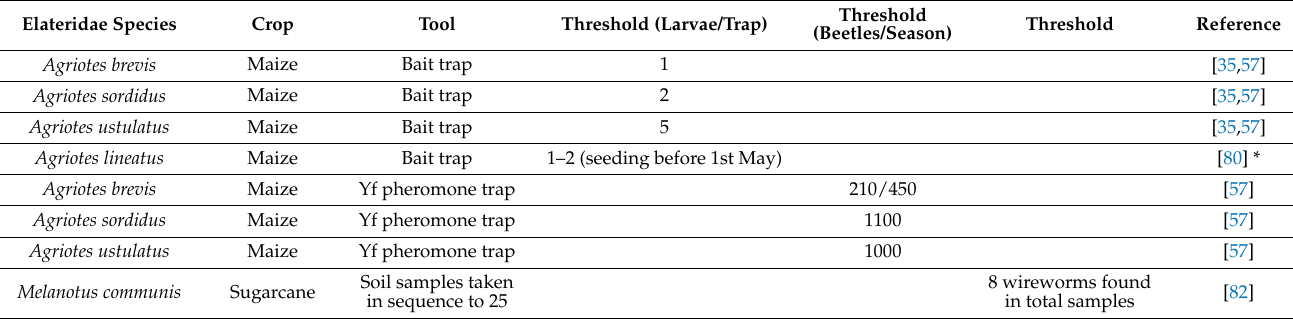
Table 2. Published damage thresholds according to click-beetle species, crop, and monitoring method. Elateridae